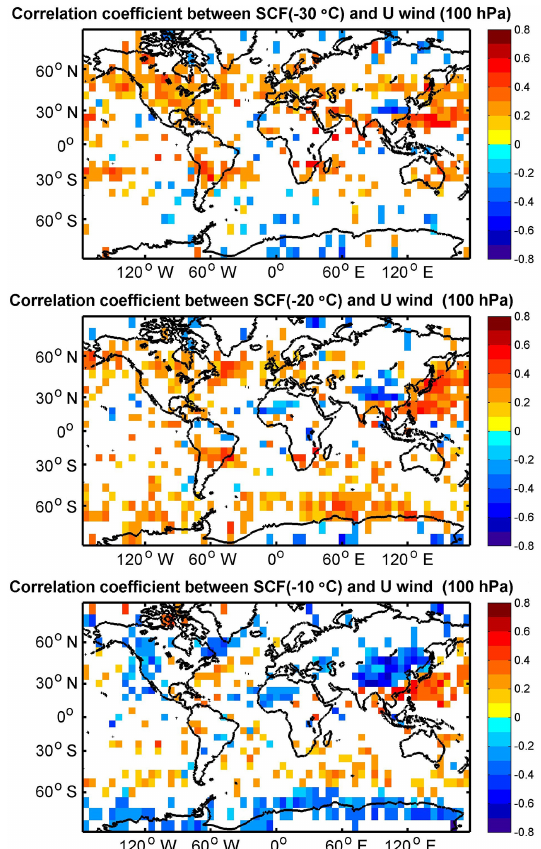
Figure 7. Similar to Fig. 5 but for U wind at